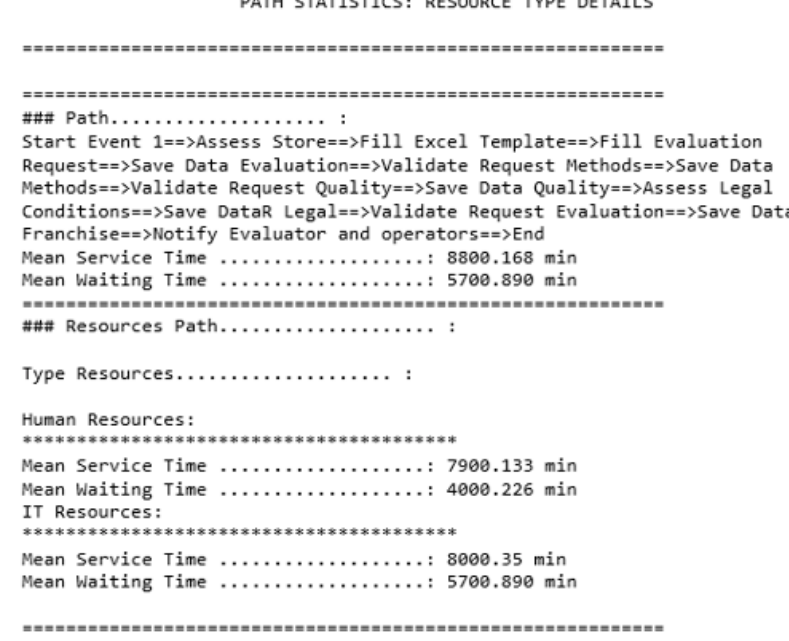
Figure 19. Global results of each type of resource for inexperienced human resource.